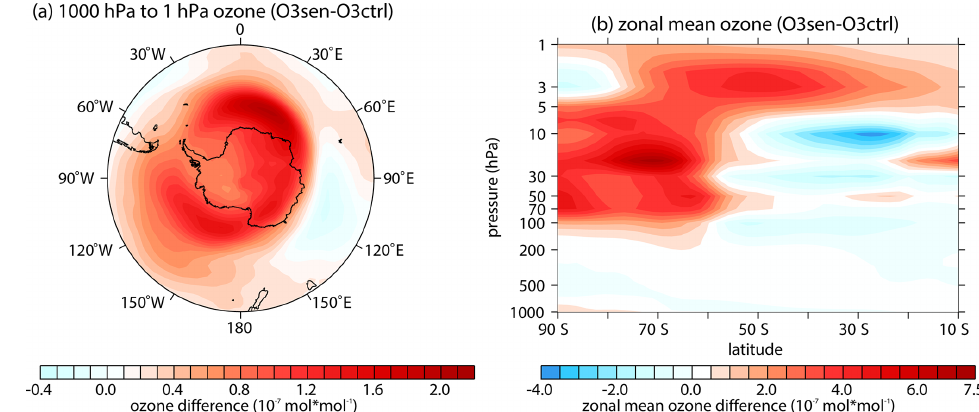
Figure 5. (a) Difference in the horizontal ozone forcing field averaged from 1000 to 1hPa between O3sen and O3ctrl. The outermost latitude in panel (a) is 40 ◦ S. (b) Zonal mean difference in the ozone forcing fields on latitude pressure profile in the Southern Hemisphere between O3sen and